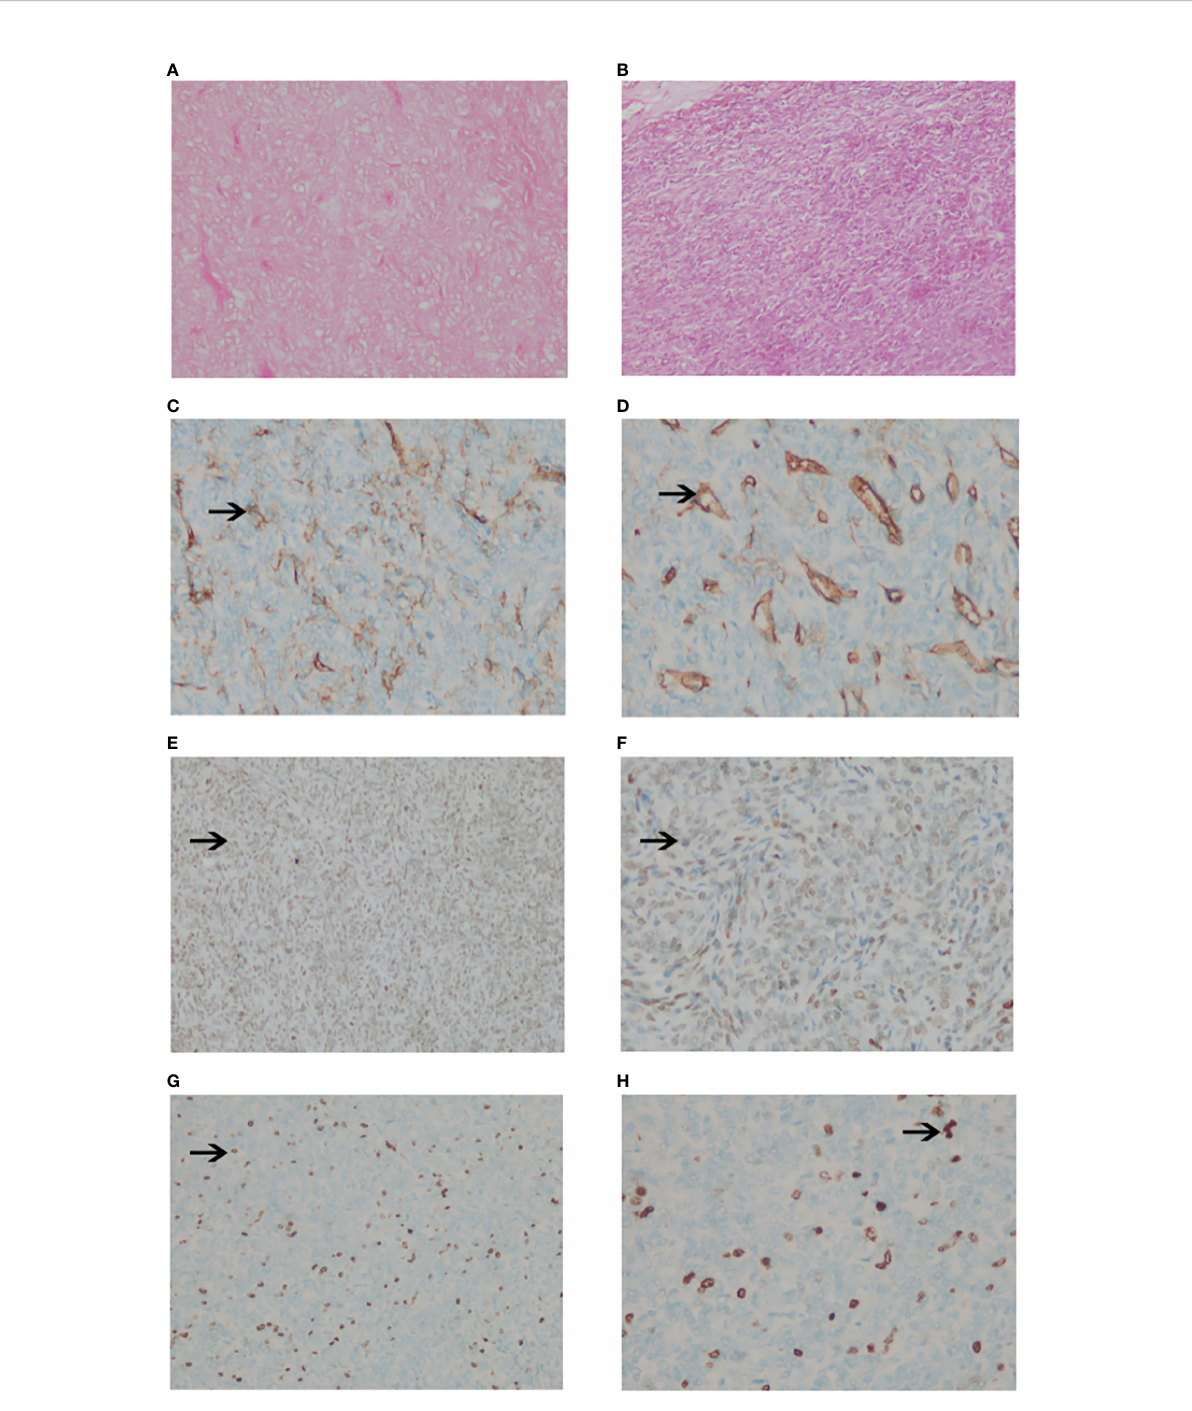
FIGURE 1 Pathological images of intracranial SPF/HPC. (A, B) . The tumor showed compact and uniform cells with a large number of small vascular cavities and compact reticular fi bers with hematoxylin and eosin stain HE×100 (A) and ×200 (B) . (C, D) . The positive staining of CD34 was brown granular in the cytoplasm (×100) (C) and (×200) (D) . (E, F) . The positive staining of STAT6 was brown granular in the cytoplasm (×100) (E) and (x200) (F) . (G, H) . Negative staining of Ki67 in tumor cells (×100) (G) and (×200) (H)